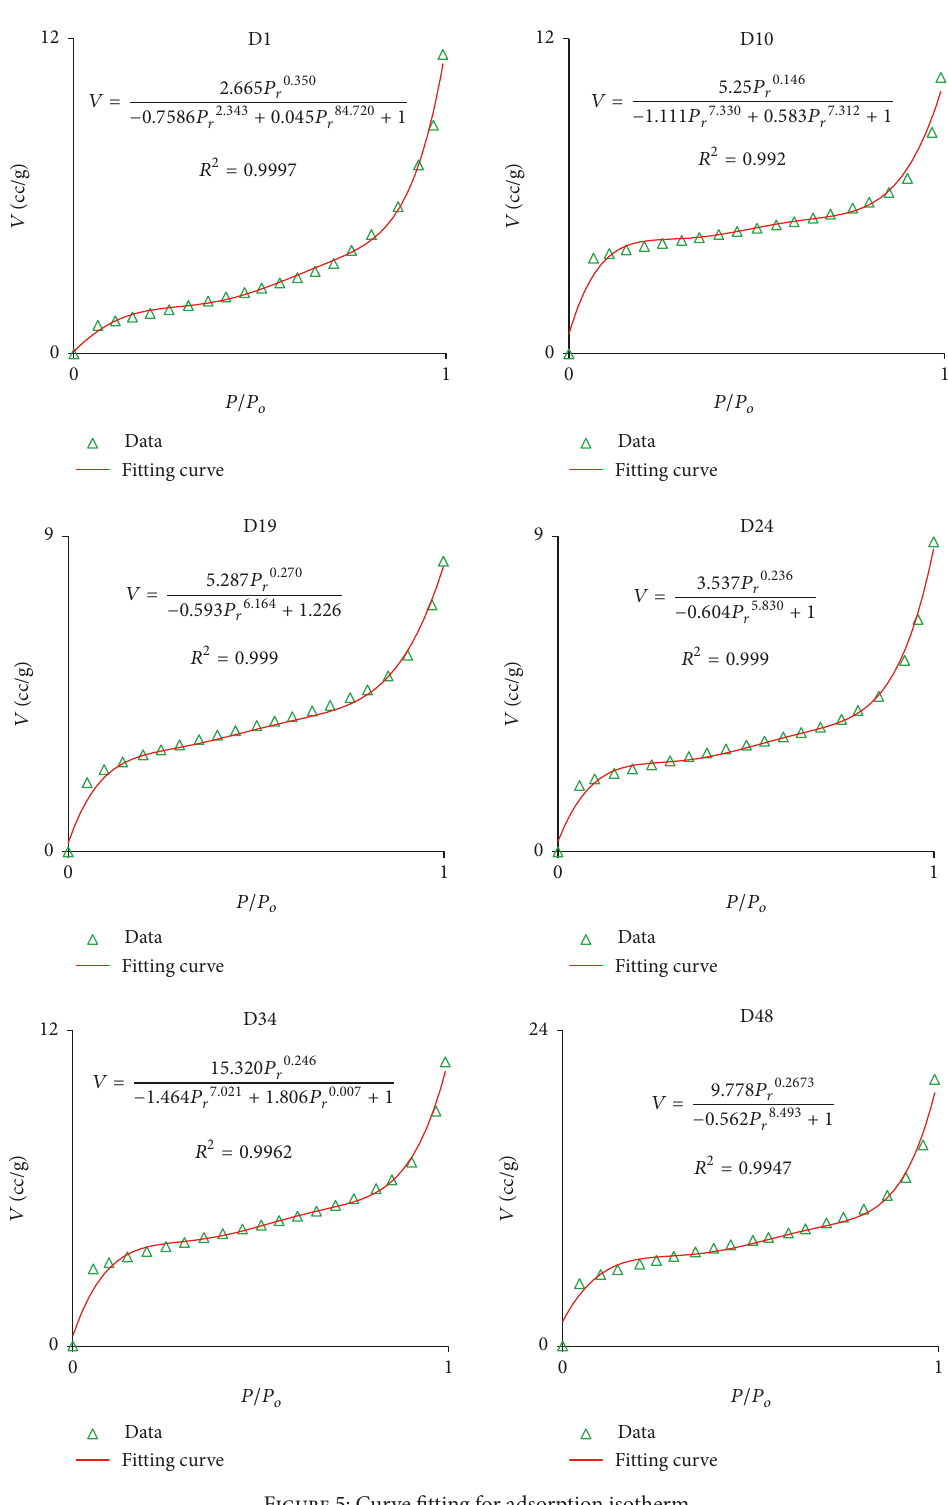
Figure 5: Curve fitting for adsorption